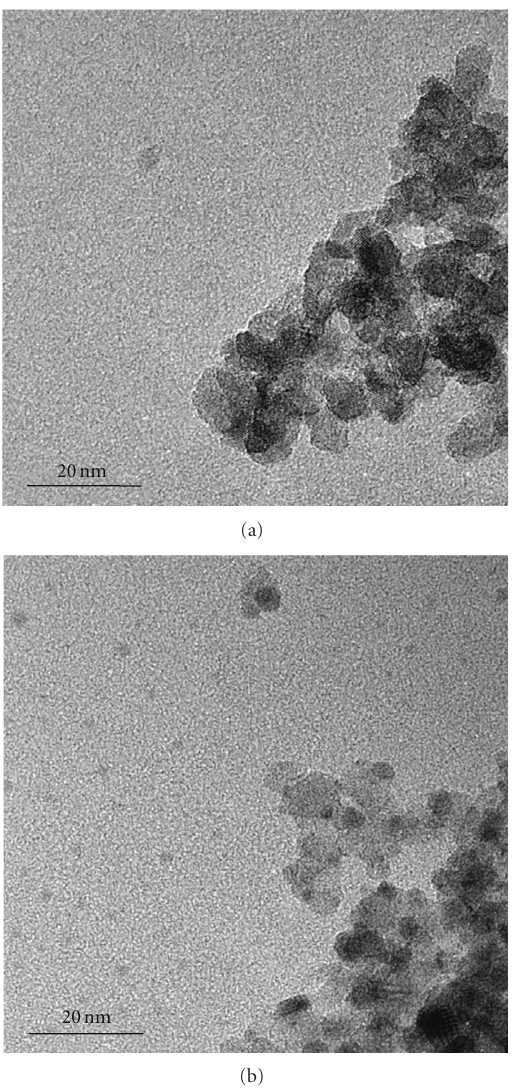
, ) desorption isotherms of (cid:0) (cid:2)